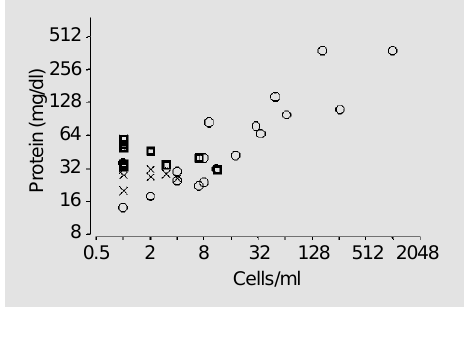
Figure 1 - Protein concentration and cell counts in CSF from patients with active (circles, N = 22) and inactive (squares, N = 13) NCC and from control subjects (X, N = 15).